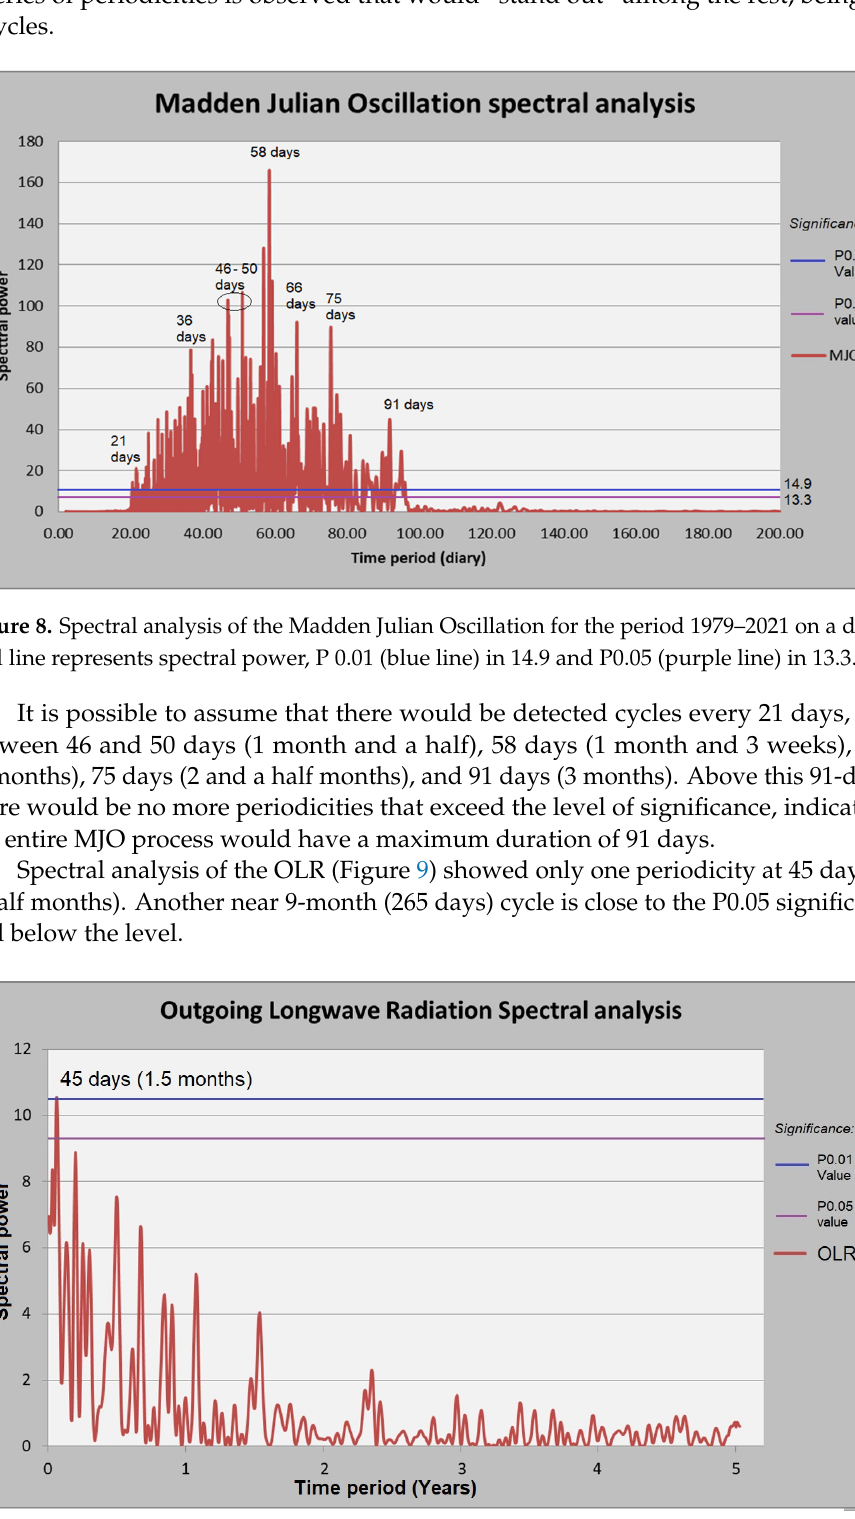
Figure 7. Spectral analysis of the SALLJ intensity for the period 1979–2018 at its own scale in which 37 values correspond to one month. The red line represents the variability of the spectral power, while the blue line represents the minimum value of significance P0.01 (11.4), and the purple line represents the minimum value of P0.05 (9.6).